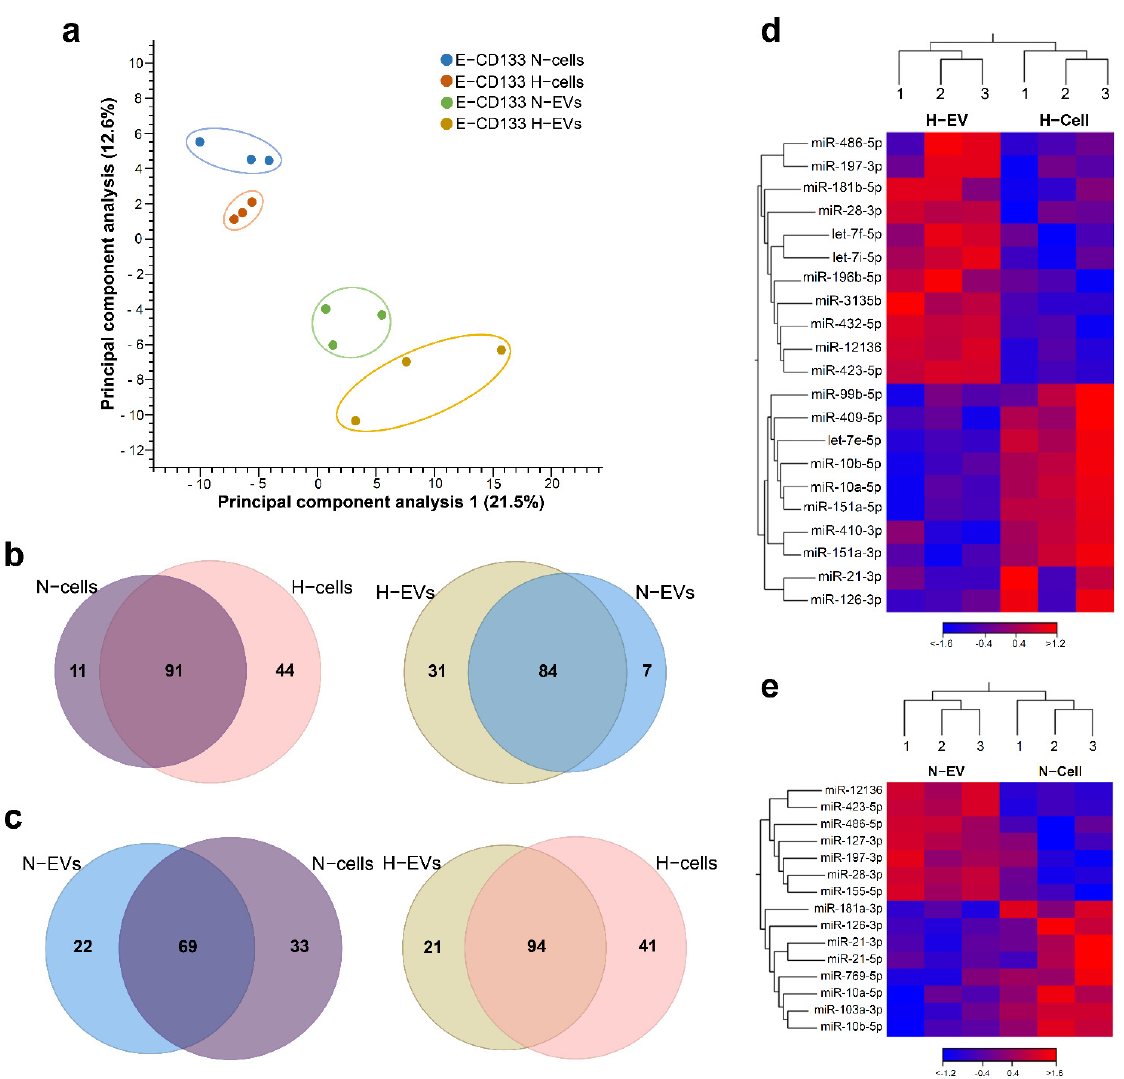
Figure 2. Comparison of miRNAs identified in normoxia and hypoxia E-CD133 cells and EVs. ( a ) Principal component analysis of miRNAs identified in the samples. ( b ) Venn diagrams comparing the identified miRNAs in E-CD133 cells ( left ) or E-CD133 EVs ( right ) in normoxia versus hypoxia culture conditions. ( c ) Venn diagrams comparing the identified miRNAs in E-CD133 cells versus E-CD133 EVs in normoxia ( left ) or hypoxia ( right ) culture conditions. ( d ) Heatmap of miRNAs differentially expressed (FDR ≤ 10%, log2(FC) < − 1 and >1) among E-CD133 cells and E-CD133 EV cultured in hypoxia. ( e ) Heatmap of miRNAs differentially expressed (FDR ≤ 10%, log2(FC) < − 1 and >1) among E-CD133 cells and E-CD133 EV cultured in normoxia.